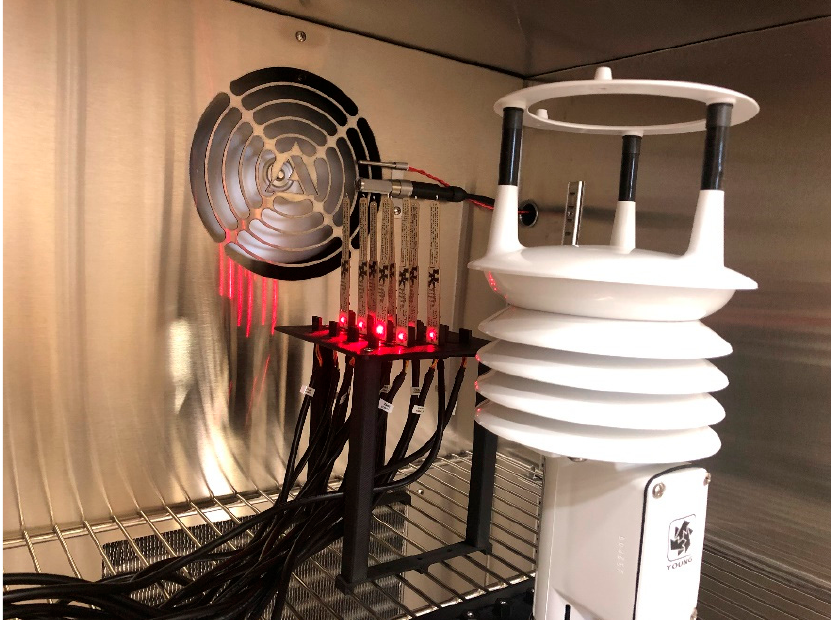
Figure 5. Eight PTH Probes in an environmental chamber. The environmental chamber’s temperature and relative humidity sensors and the weather station’s barometric pressure sensor were used as reference instruments for calibration and validation. The weather station’s ultrasonic anemometer also confirmed that airflow exceeded 1.0 m/s to achieve manufacturer-specified sensor response times.